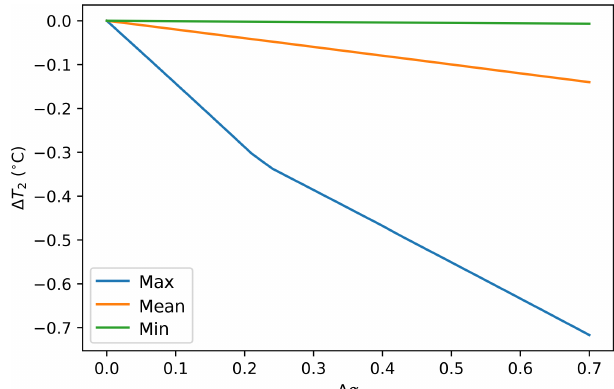
Figure 4. Comparison of execution times (seconds) between serial and parallel modes when 12 grids are simulated for different periods (days): 30, 90, 120, 150, 180, 270, 365, 730 and 1095. Simulations performed with macOS 10.14.3 running on 2.9GHz Intel Core i9 with 32GB memory. The model configuration is the same as Quick- start SuPy (Table 2).